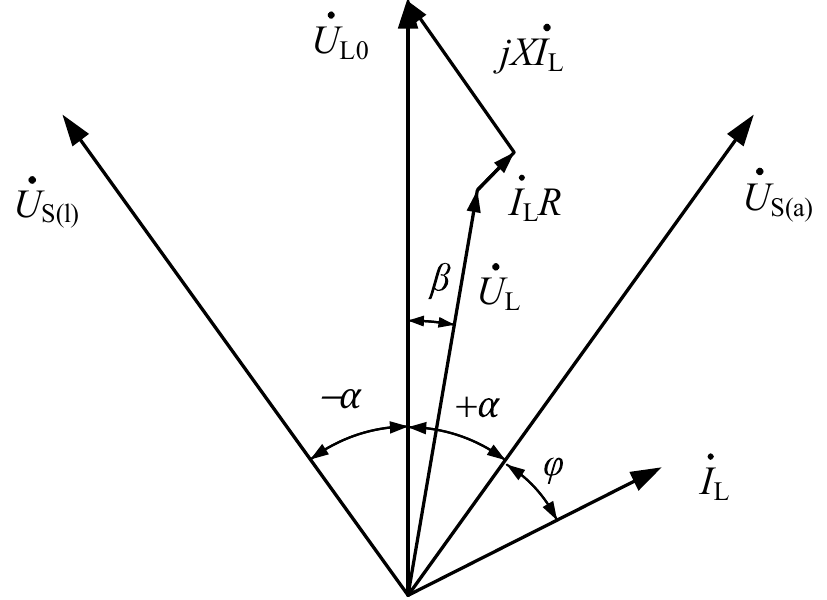
Figure 7. Phasor relation considering internal impedance .